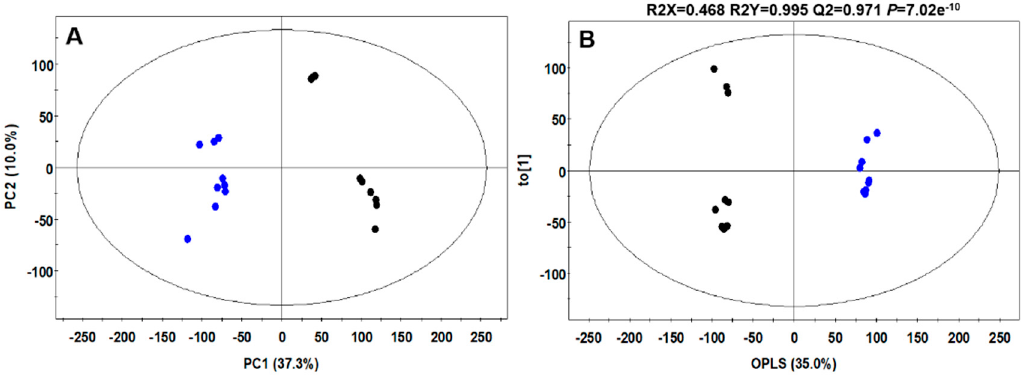
Figure 4. ( A ) Principal component analysis (PCA) and ( B ) orthogonal partial least squares-discriminant analysis (OPLS-DA) score plots derived from ultra-high-performance liquid chromatography-linear trap quadrupole-orbitrap-tandem mass spectrometry (UHPLC-LTQ-Orbitrap-MS / MS) datasets of NCC and LpCC extracts in negative ion mode ( • ,NCC; • , LPCC).